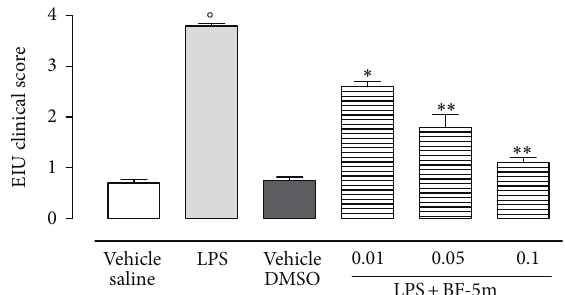
Figure 2: Clinical score attributed to EIU after intravitreal BF-5m. Sprague-Dawley rats were treated with vehicle (saline), LPS (200 𝜇 g/rat), vehicle (1% DMSO), and LPS+BF-5m (0.01; 0.05; 0.1 𝜇 M/rat) 1h following LPS treatment and were evaluated 24 h after injections. Clinical score to EIU has been reported in the test (see Material and Methods). Values are mean ± SEM, of 𝑛 = 6 observation for each experimental group. ∗ 𝑃 < 0.05 and ∗∗ 𝑃 < 0.01 compared with LPS-treated group; ∘ 𝑃 < 0.01 versus vehicle saline